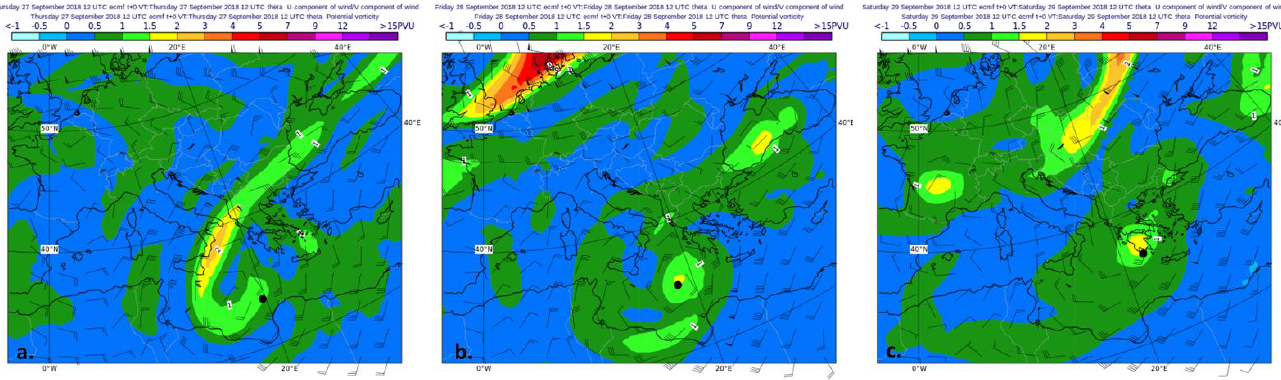
Figure 8. PV distribution on the isentropic level 315 K at ( a ) 27/12 UTC, ( b ) 28/12 UTC, and ( c ) 29/12 UTC. Black dot on the